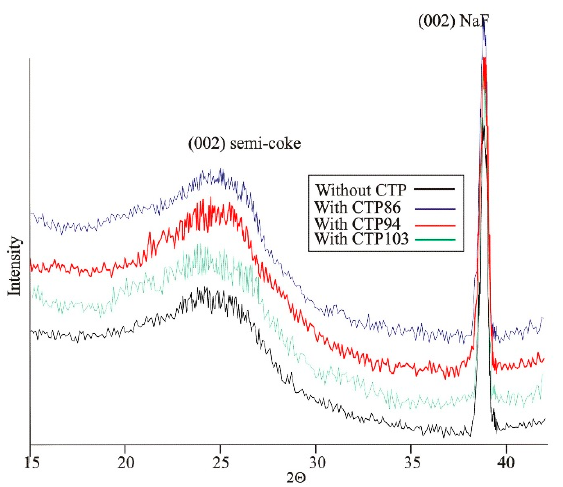
Figure 11. Diffractograms of semi-cokes from carbonized charge of coal and its blends with CTPs. The data in Table 4 imply that all CTPs behave as plasticizing agents with regard to coal and facilitate a better ordering of the structure of semicokes. Table 4. The structural parameters of obtained semi-cokes. Samples d 002 , Å C cryst , % Semi-coke from charge without CTPs